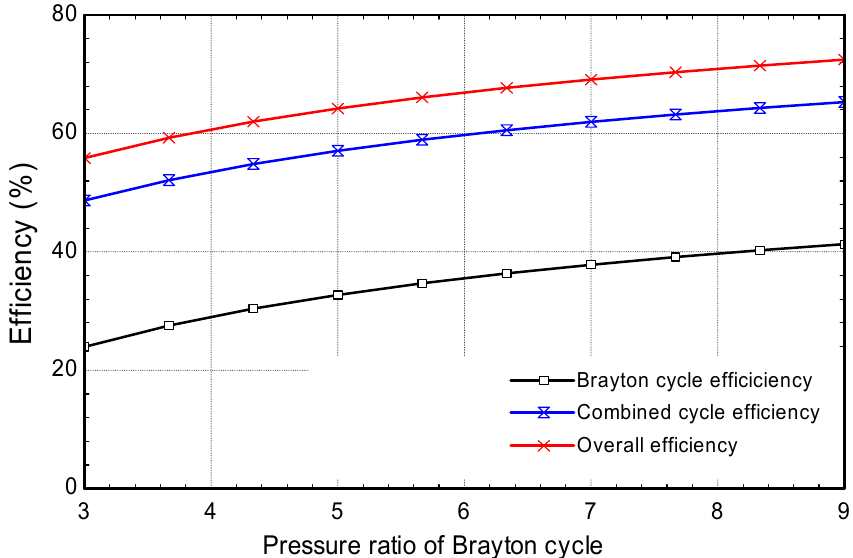
Figure 3. Impact of varying the pressure ratio of the Brayton cycle on the Brayton cycle efficiency, combined cycle efficiency, and the efficiency of the overall system.